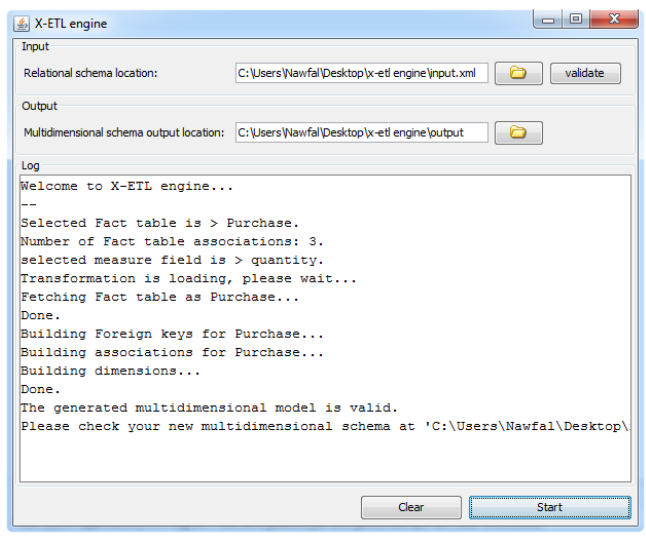
Fig. 6. The X-ETL